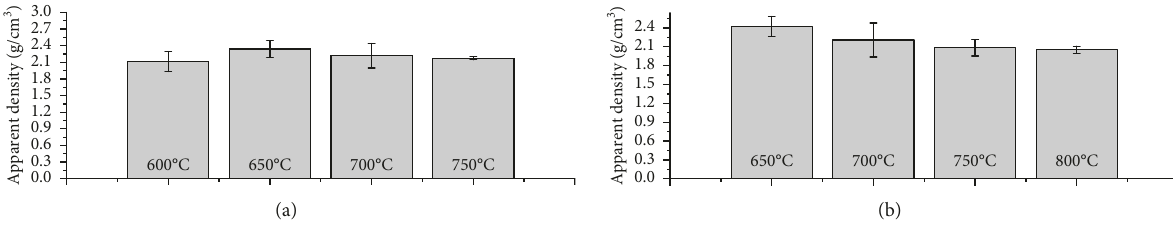
Figure 3: Variation of the density with the sintering temperature.